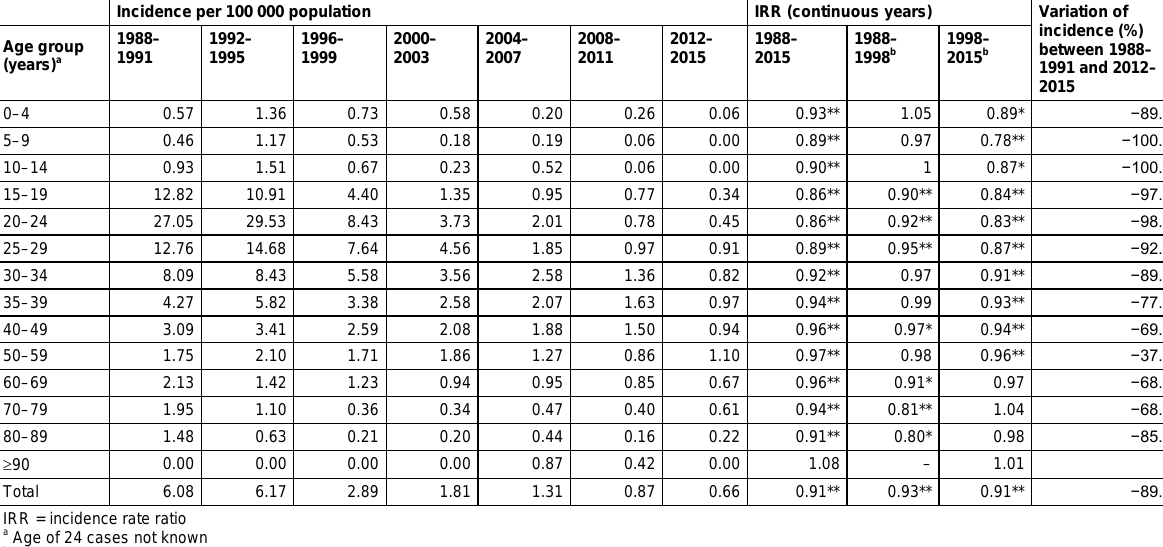
Table 2: Annual incidence development of acute hepatitis B virus infection per 100 000 population by age in Switzerland, 1988–2015. Incidence per 100 000